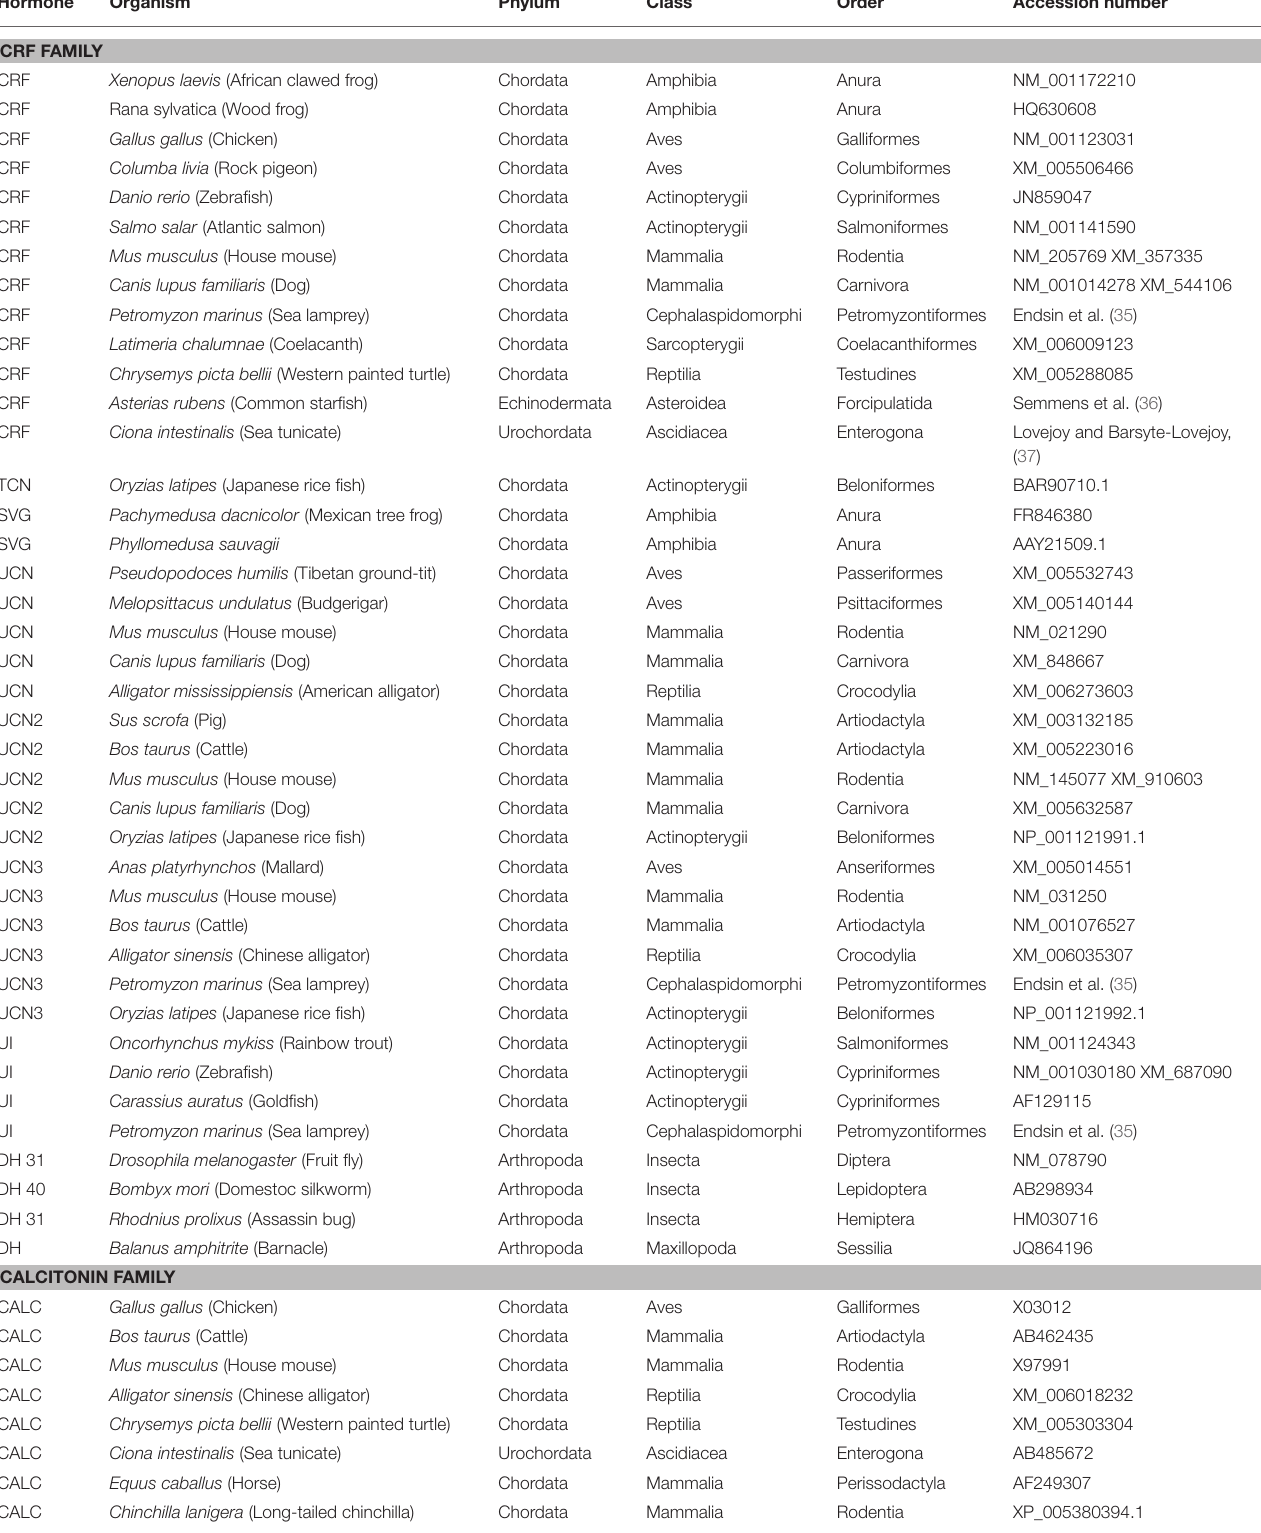
TABLE 1 | List of Sequences used to construct phylogenetic trees.